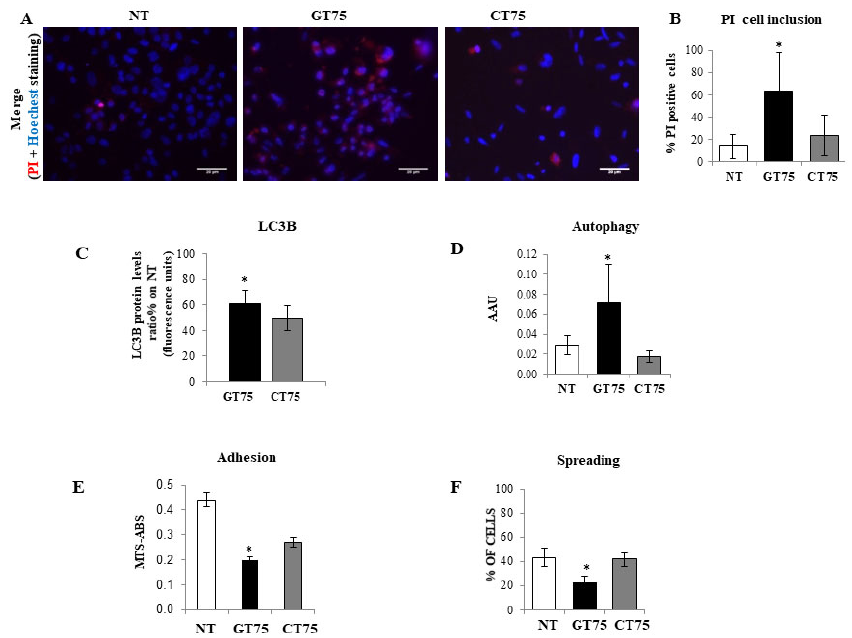
Figure 4. Effects of eEF1A1 targeting by GT75 on cell damage, autophagy, adhesion, and spreading in PC-3 cells. ( A , B ) Propidium iodide (PI) nuclei inclusion, indicating cell membrane damage, observed in GT75-treated cells (150 nM) compared with non-treated (NT) and control CT75-treated cells (150 nM) 6 days after transfection. Data in ( B ) are shown as the mean ± SD, n = 3. ( C ) Effect of GT75 on the protein level of the autophagy marker LC3B 3 days after transfection. ( D ) Effect of GT75 on the cell autophagy rate evaluated by autophagy colorimetric assay 3 days after transfection. ( E ) Effect of GT75 on cell adhesion compared with NT and control CT75-treated cells 24 h days after transfection. Data in ( C – F ) are shown as the mean ± SD, n = 8. * p < 0.05 compared with CT75-treated cells.